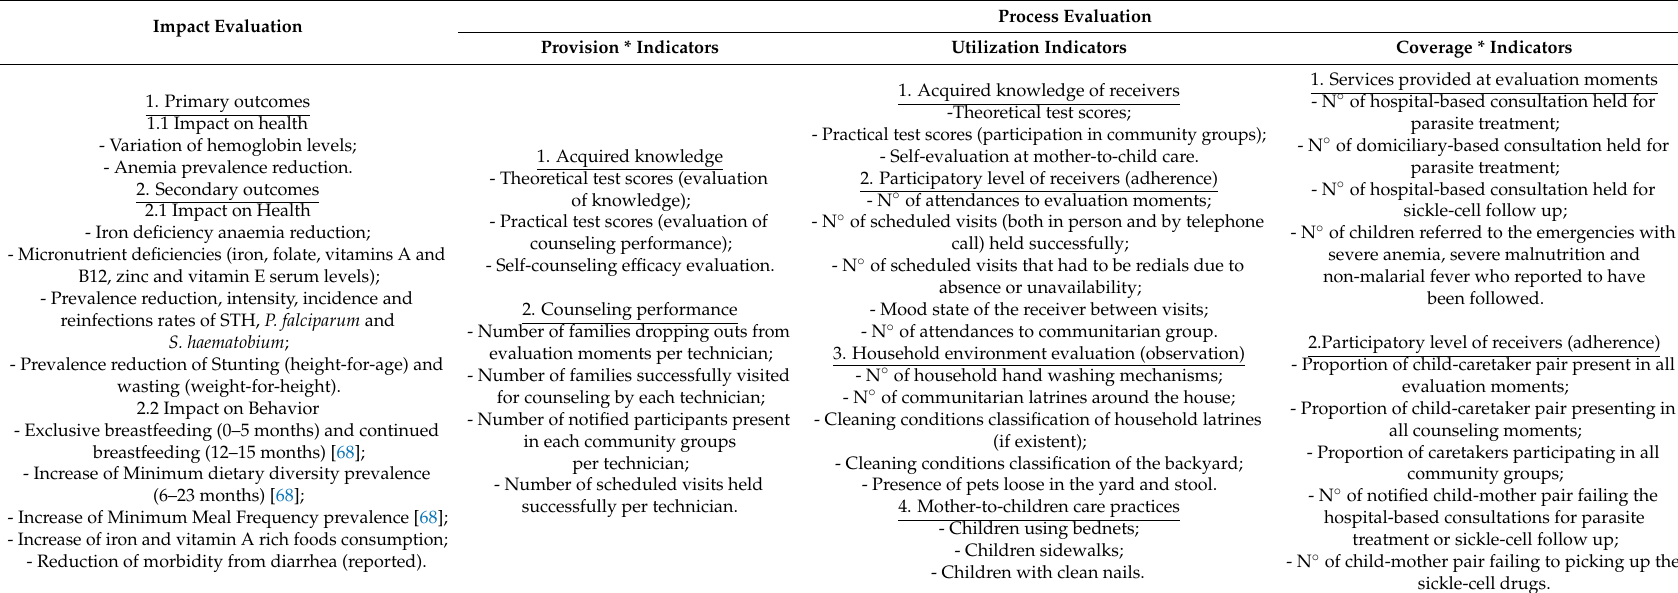
Table 2. Indicators of impact, provision, utilization and coverage being collected in this